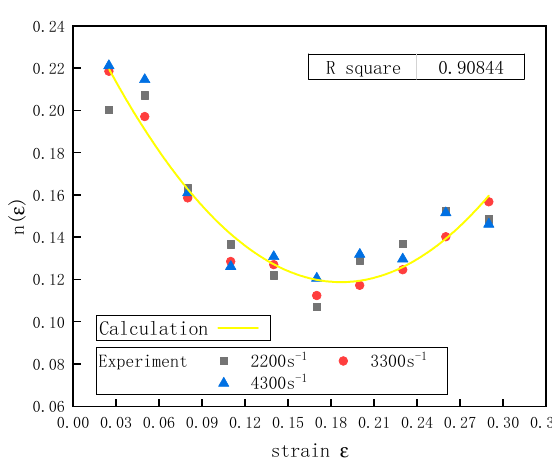
Figure 8. The relationship between n ( ε ) and ε at a temperature of 20 ◦ C and di ff erent strain rates.